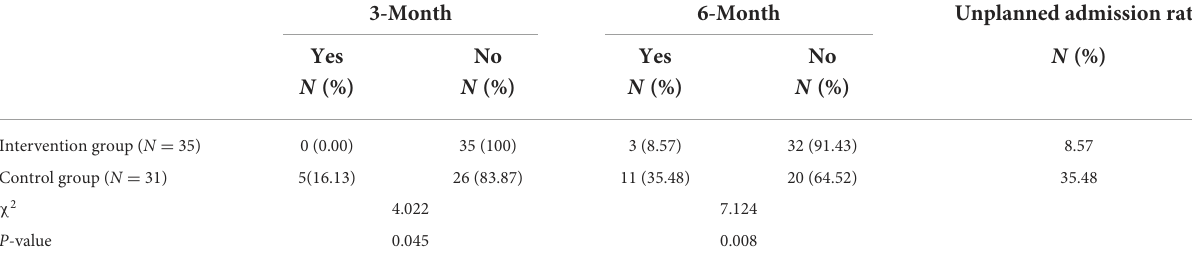
TABLE 4 The change of unplanned admission at third and sixth month among PCOS